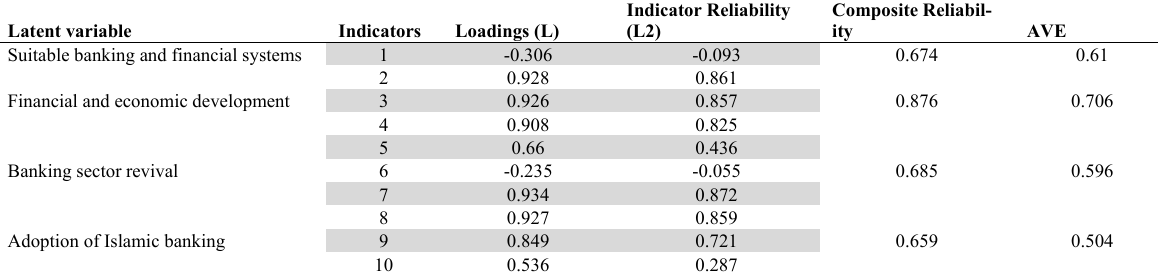
Results Summary for Reflective Outer